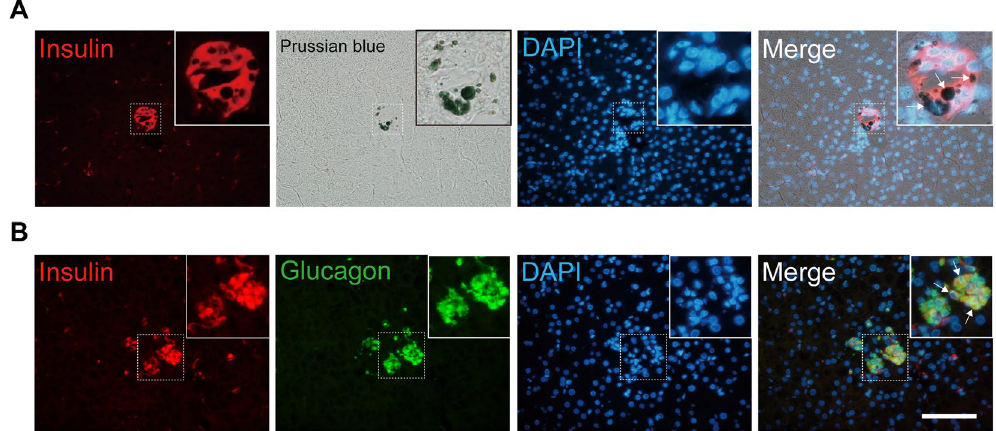
Figure 4. Histology and immunochemical staining of transplanted ICCs. ( A ) The colocalization of insulin activity and SPIONs was verified by double staining with immunofluorescence staining with anti-insulin antibodies (red fluorescence) and Prussian blue staining for iron (blue). White arrows showed where iron particles were located within the insulin-positive cells. ( B ) Immunostaining for insulin (red fluorescence) and glucagon (green fluorescence) revealed the expression of islet hormones in the transplanted ICCs. Note that some of insulin-positive cells co-expressed glucagon (indicated by white arrows). Cell nuclei were visualized using DAPI staining (blue fluorescence). Insets showed magnified views of indicated area. Scale bar represents 100 μ m.